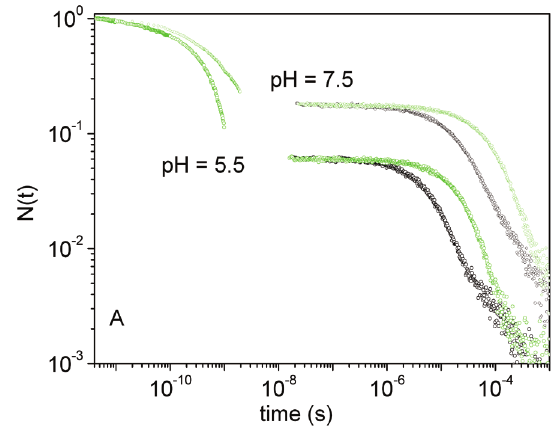
Figure 9. Ligand rebinding kinetics. Complete rebinding kinetics to NP7 at pH 7.5 and pH 5.5 ( T = 20°C). The experimental progress